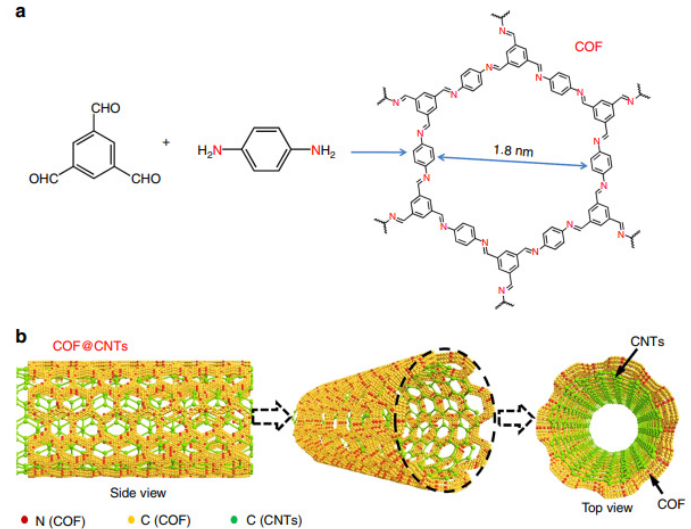
Figure 7. Preparation of the COF and COF@CNTs composite. ( a ) Preparation of COF with a 2D structure and an average pore size of 1.8 nm; ( b ) graphical representation of the COF@CNTs anode material with few COF layers covered on the exterior surface of carbon nanotubes [91]. Ref. [91] is permits unrestricted use, distribution, and reproduction in any medium provided the original work is properly